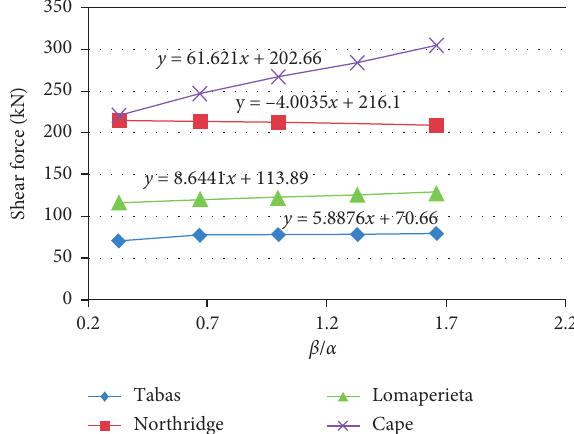
Figure 17: Maximum shear force of tunnel lining ( F ) at load combination 6 to